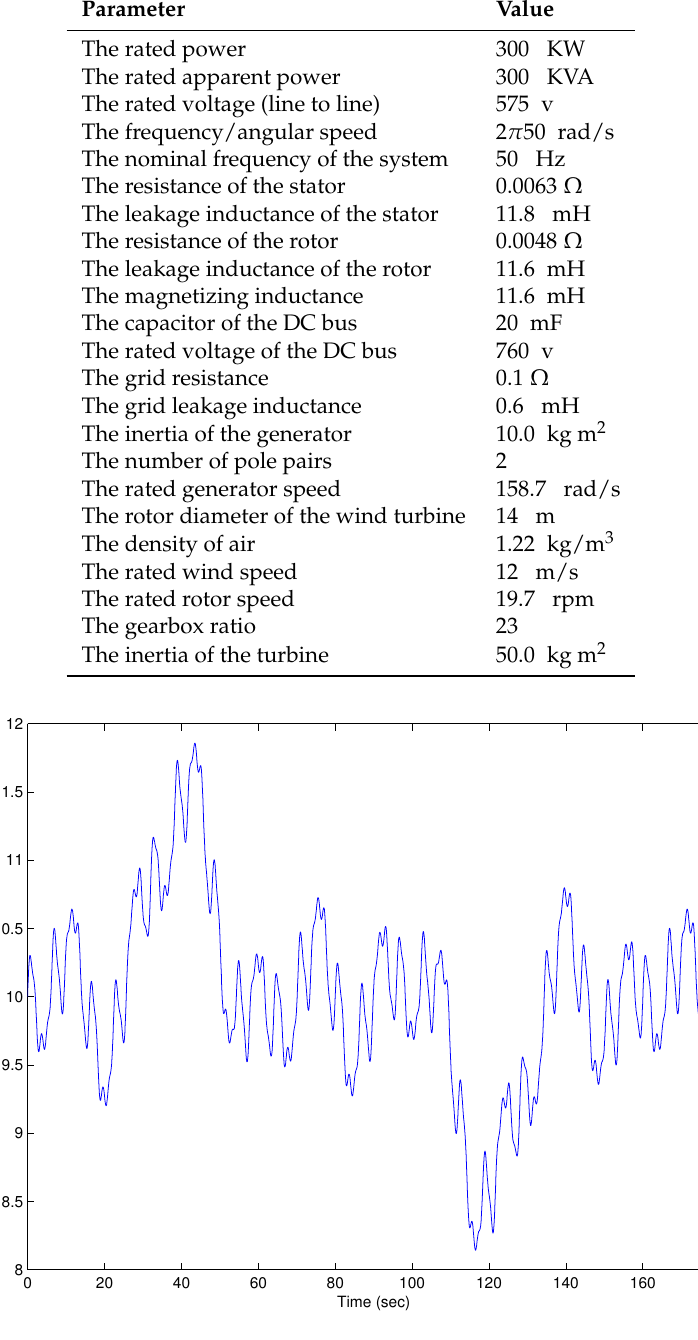
Figure 5. The profile of the wind speed versus